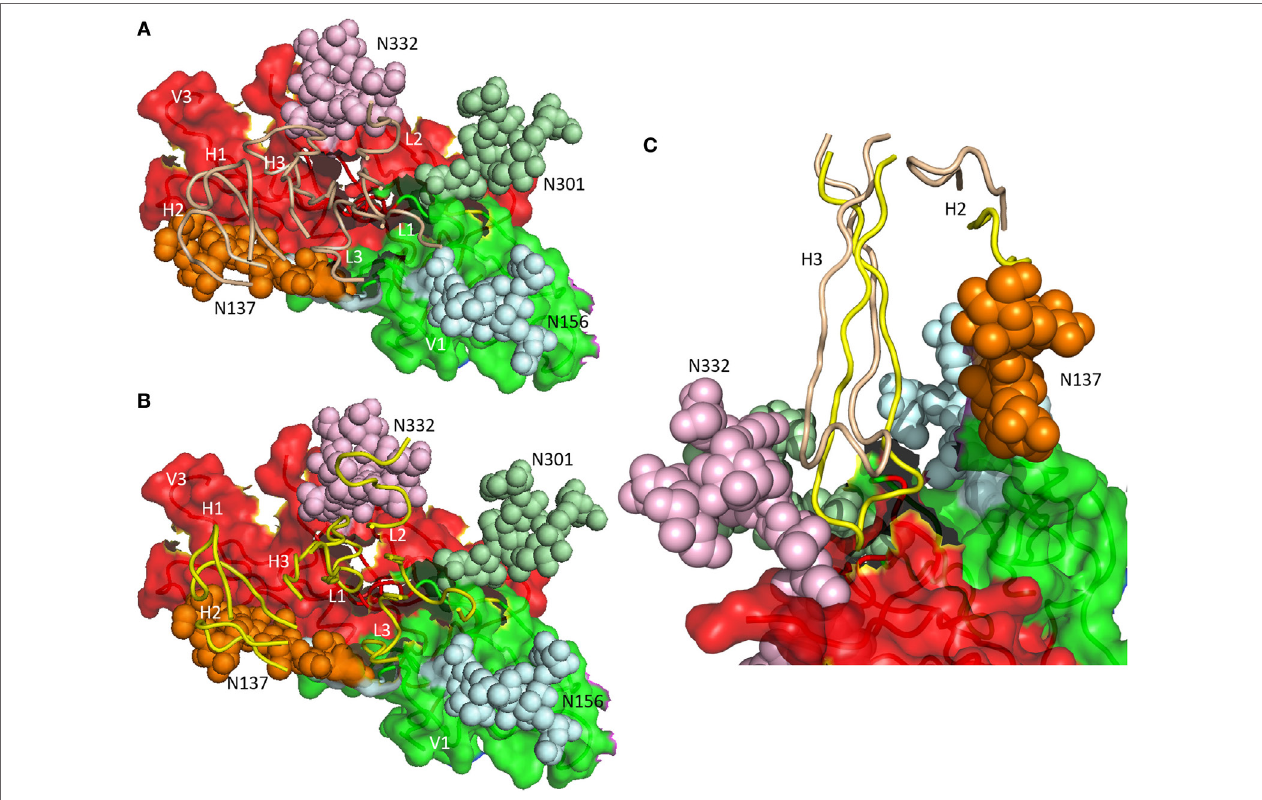
FiGURe 3 | Differential glycan recognition by affinity-matured antibodies. (A) Positions of complementarity-determining region (CDR) loops (wheat) of matured antibody PGT124 on envelope glycoprotein (Env) gp120 (4R2G) (16). V L CDR loops are labeled L1–L3; V H CDR loops are labeled H1–H3. The V1 (green) and V3 (red) regions of gp120 are depicted as molecular surfaces. Glycans are drawn as spheres and labeled N137, N156, N301, and N332. The PGT124 epitope is composed of V1, V3, and the N332 glycan. (B) Positions of CDR loops (yellow) of matured antibody PGT122 on Env gp120 (4NCO) (15). The PGT122 epitope is composed of V1 and V3, as well as all four glycans at N137, N156, N301, and N332. (C) V H CDR3 of PGT122 (yellow) contacts both the N137 and N332 glycans. V H CDR3 of PGT124 (wheat) contacts only the N332 glycan due to a shift in position relative to V H CDR3 of PGT122.